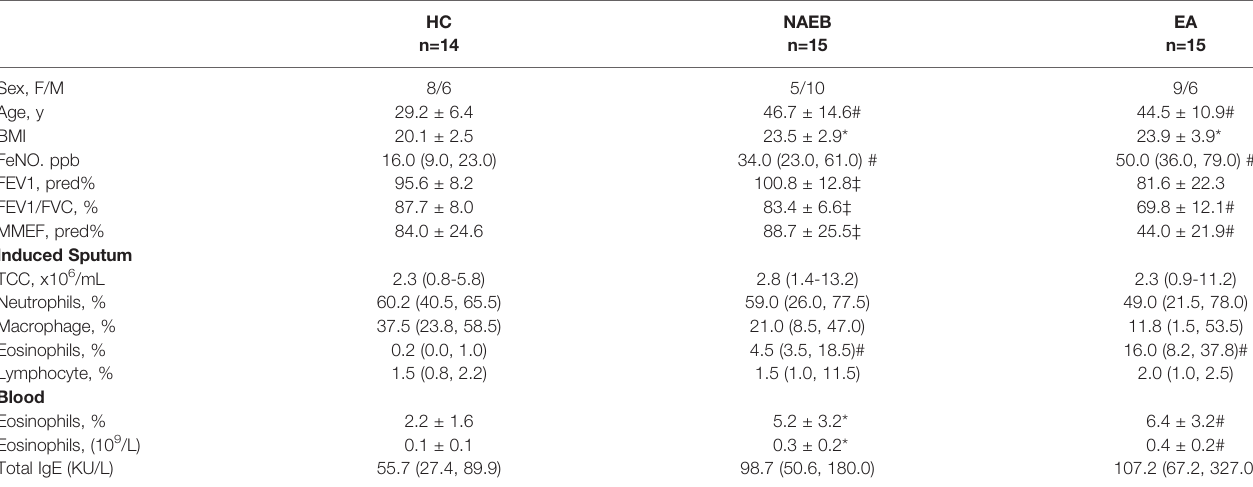
TABLE 1 | Demographics and clinical characteristics at